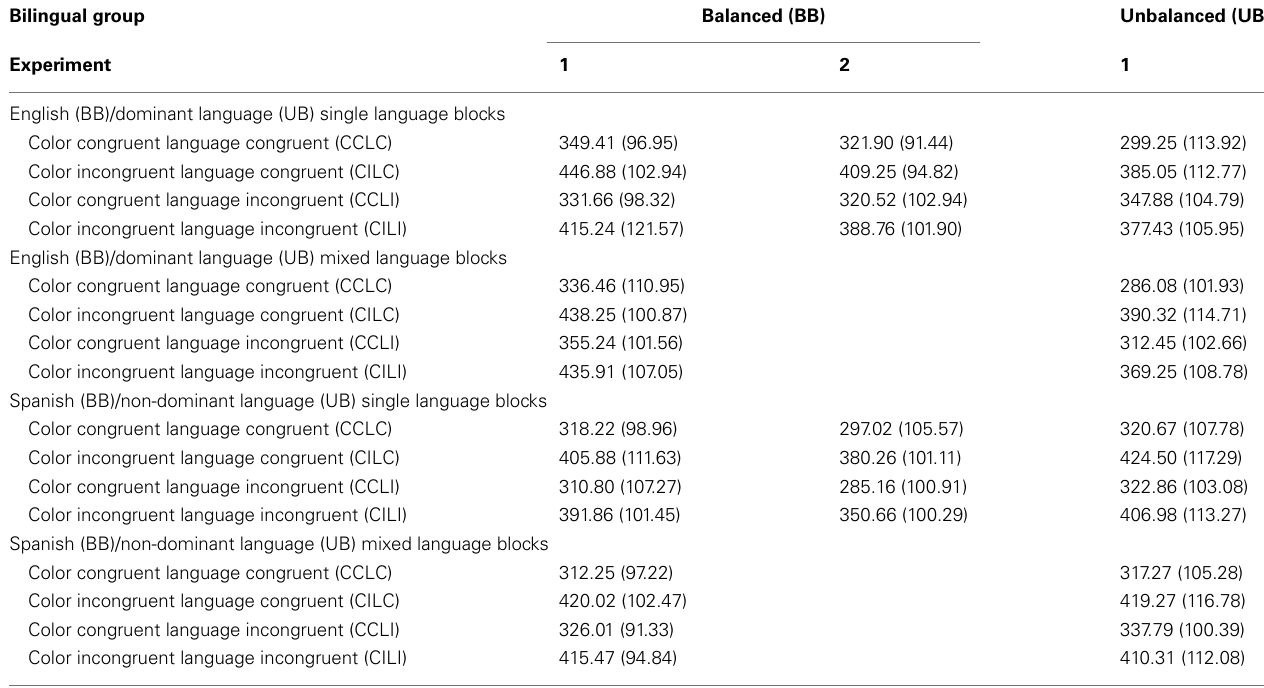
Table 3 | Simple effects means (SD) in